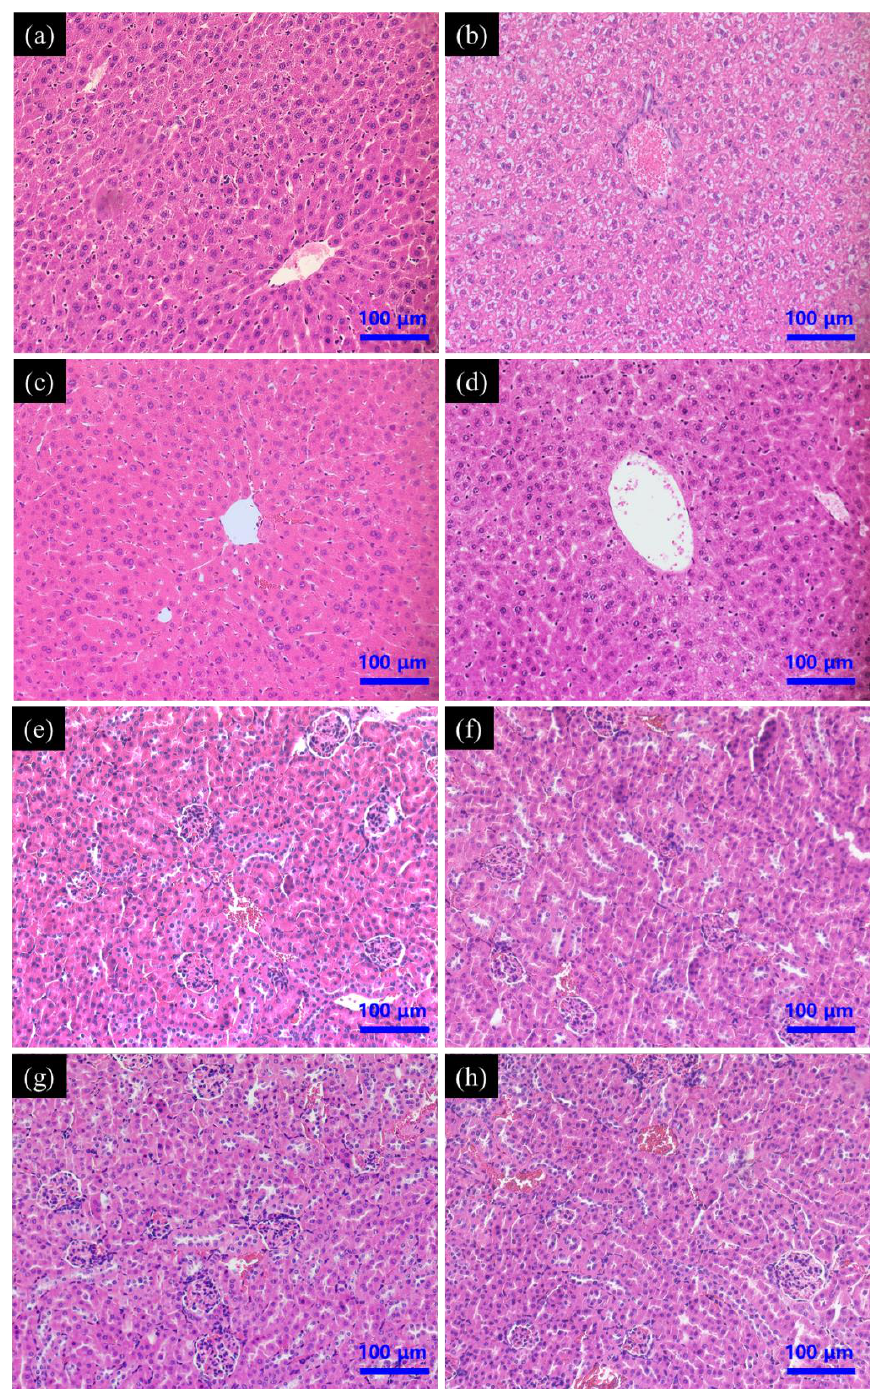
Figure 5. Effect of SeNPs on PAT-evoked pathological damage of ( a – d ) liver and ( e – h ) kidney tissue as assessed by H&E staining. Control group ( a , e ); PAT treatment group ( b , f ); SeNPs treatment group ( c , g ); SeNPs pre-treatment followed by PAT administration ( d , h ).